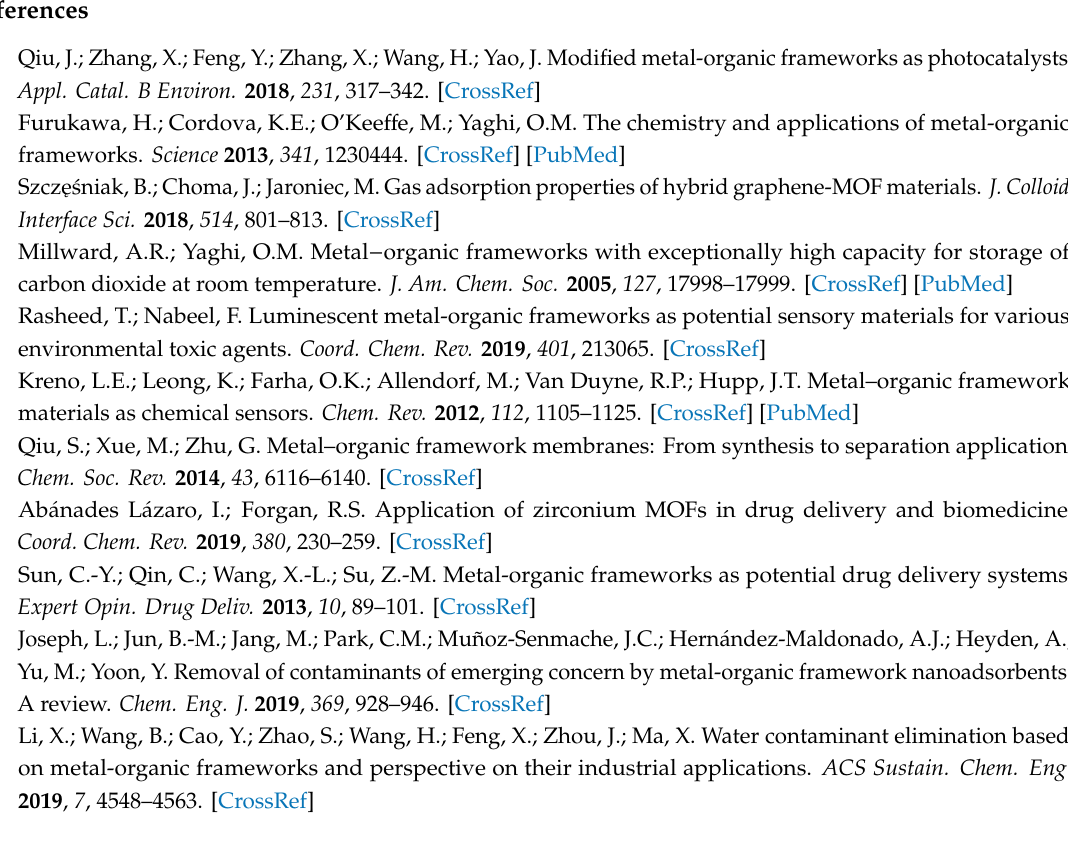
Figure S1: UV–vis di ff use absorbance spectra of NH 2 -MIL-125(Ti) treated under vacuum at di ff erent temperatures for 16 h. Original NH 2 -MIL-125(Ti) and MIL-125(Ti) spectra are included as reference, Figure S2: UV–vis di ff use absorbance spectra of NH 2 -MIL-125(Ti) heated in air at di ff erent temperatures for 16 h ( a ) and at 250 ◦ C for 48 and 72 h ( b ). Original NH 2 -MIL-125(Ti) and MIL-125(Ti) spectra are included as reference, Figure S3: UV–vis di ff use absorbance spectra of M-250-48 before and after contact with water for 24 h. Original NH 2 -MIL-125(Ti) and MIL-125(Ti) spectra are included as reference, Figure S4: ( a ) Chemical structure of Ti-oxo clusters linked to NH 2 -BDC ligands, from the Cambridge Structural Database (CSD). Chemical structure of NH 2 -MIL-125(Ti) viewed from a-axis ( b ) and c-axis ( c ), from cif data of Crystallography Open